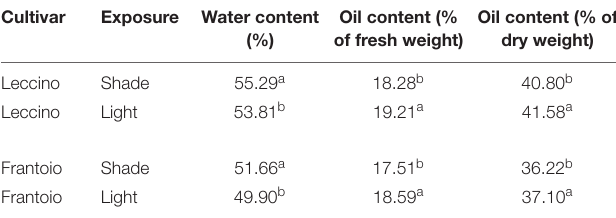
FIGURE 5 | Semi-thin sections at 80 DAF of Leccino (A,C,E,G) and Frantoio (B,D,F,H) fruits in light (A,B,E,F) , and shade (C,D,G,H) conditions. Oil drops were uniformly distributed in the mesocarp (A–D) and occupied a larger fraction of the cell volume in Frantoio (F,H) than in Leccino fruits (E,G) ; endocarp was almost completely lignified (M). (D) is stained with osmium, while the others are stained with toluidine blue.